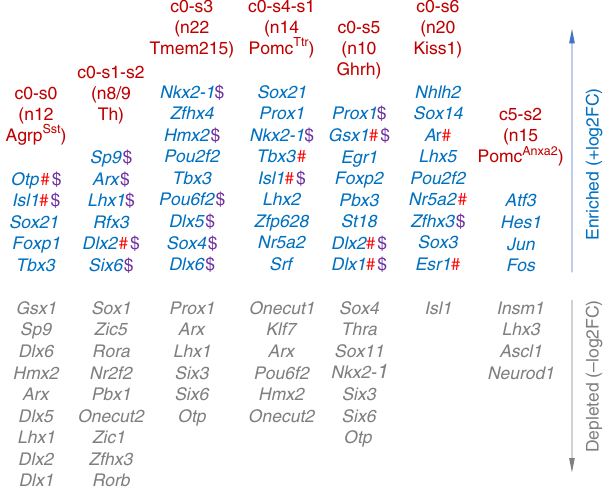
Fig. 4 Transcription factors enriched in E15 developing ARC neurons. We listed transcription factor transcripts in the subclusters c0-s0, c0-s1, c0-s3, c0-s4, c0-s5, c0-s6, and c5-s2, which show relatively stronger similarity to adult ARC neurons. Transcripts for the transcription factors that have been already implicated in the development of ARC neurons are denoted by #, while transcripts for the transcription factors showing the unique expression pattern of being enriched in one or more subclusters while being excluded from other subclusters are highlighted as